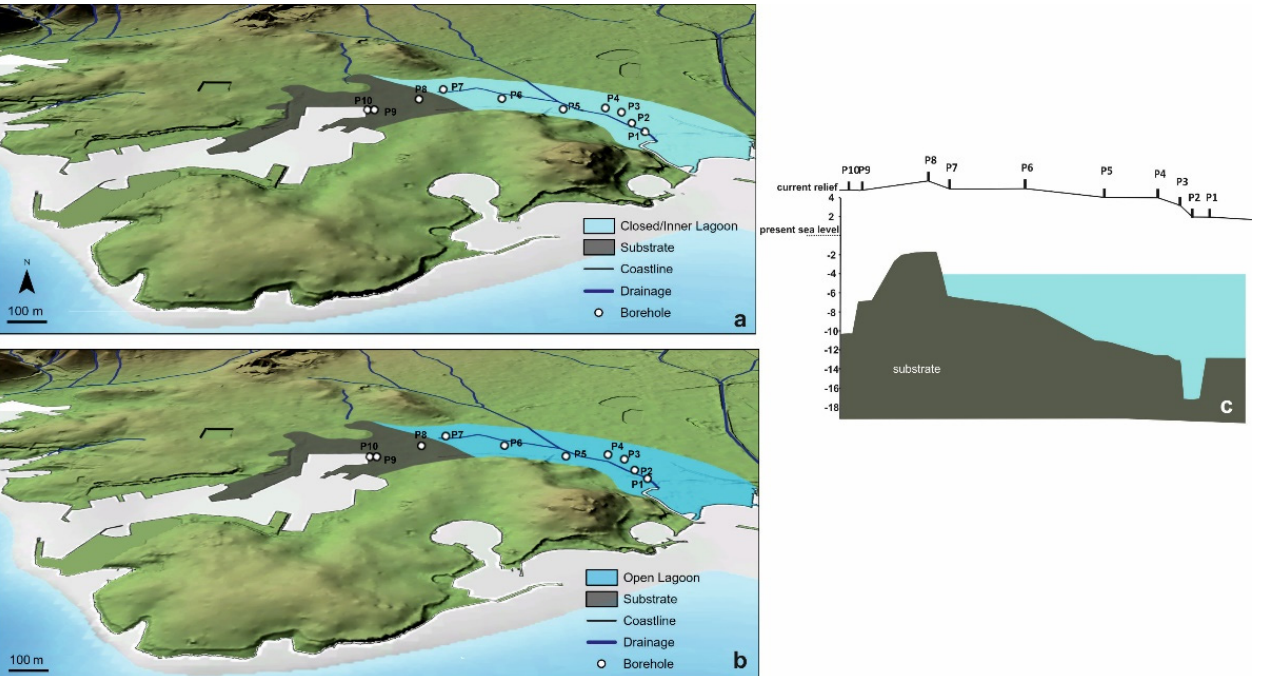
Figure 8. Paleogeographic reconstruction of the First Stage of the Piraeus Lagoon in respect to the present coastline: ( a ) The closed lagoonal environment of Unit Aa; ( b ) the mesohaline open lagoonal environment of Unit Ab; ( c ) Simplified sketch-transect showing the development of the First Stage of Piraeus Lagoon (8700–7500 cal BP), restricted at the eastern part of the plain (depths according Goiran et al. [28]).